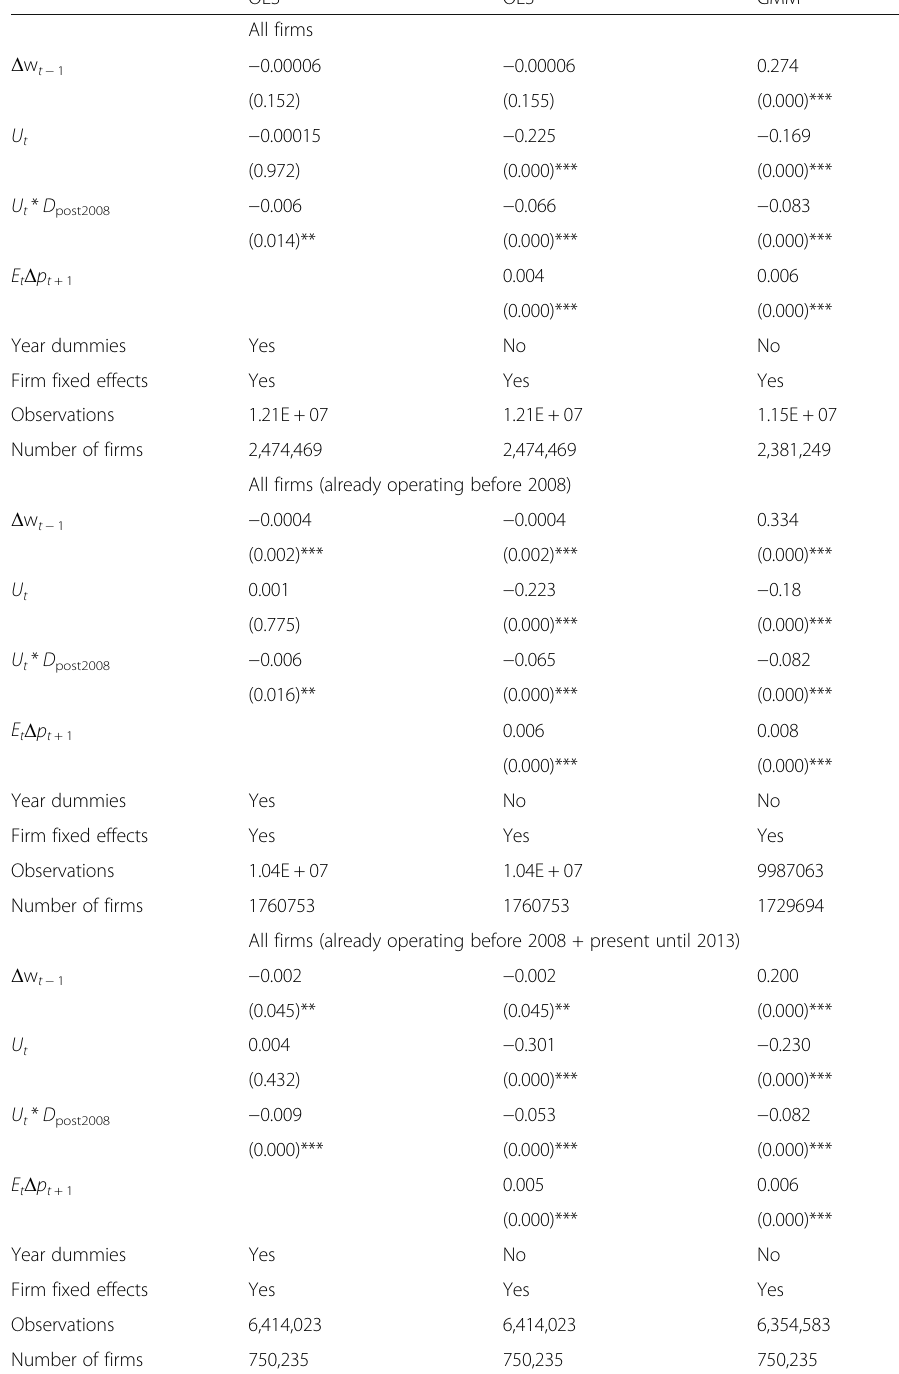
Table 3 Wage Phillips curve in Italy: firm-level estimates ( p values in brackets) OLS